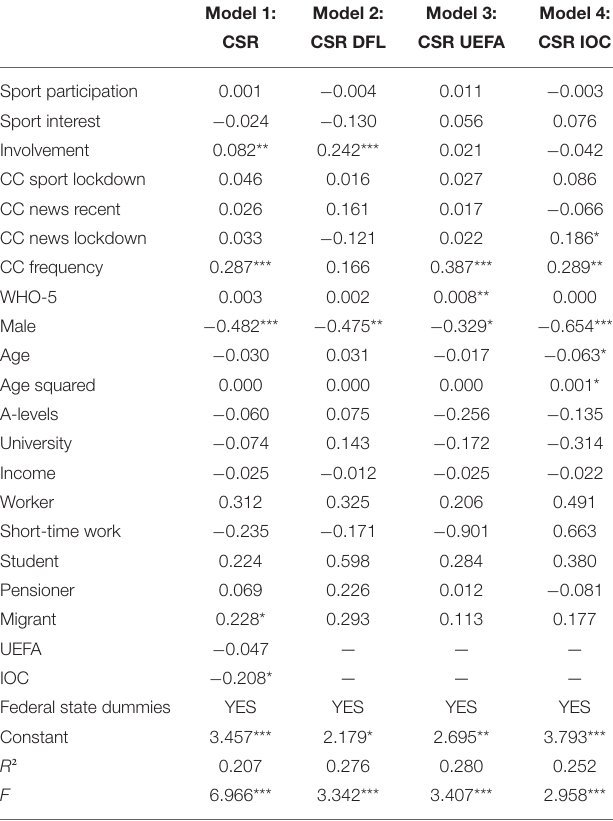
TABLE 8 | Regression models for perceived